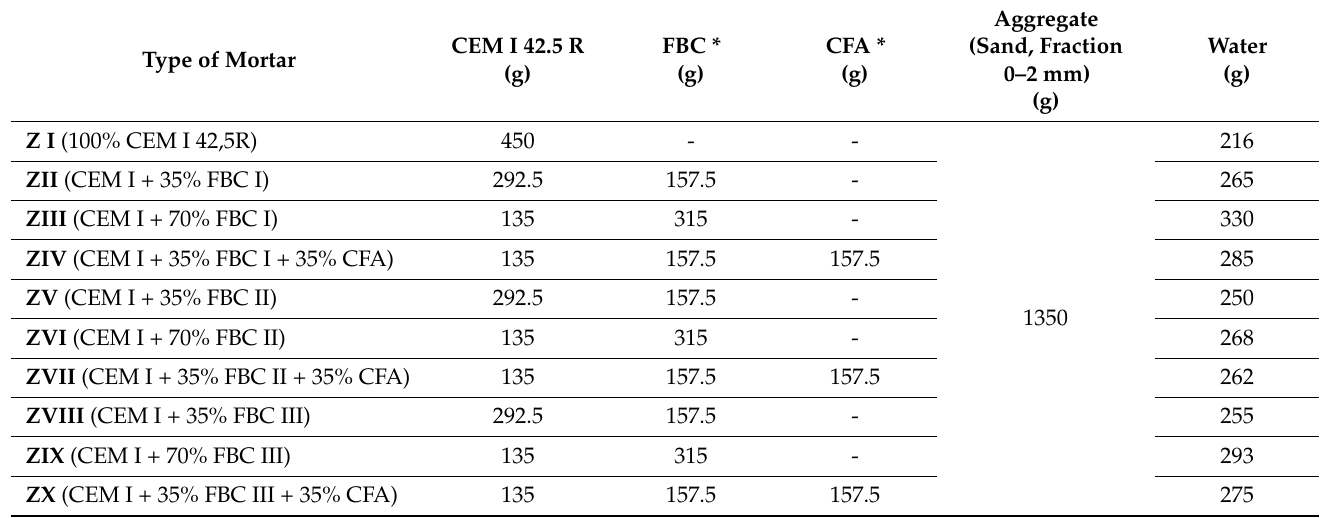
Table 1. Composition of mortars with fluidized bed combustion fly ash (FBC I, FBC II, FBC III) and siliceous fly ash (CFA).